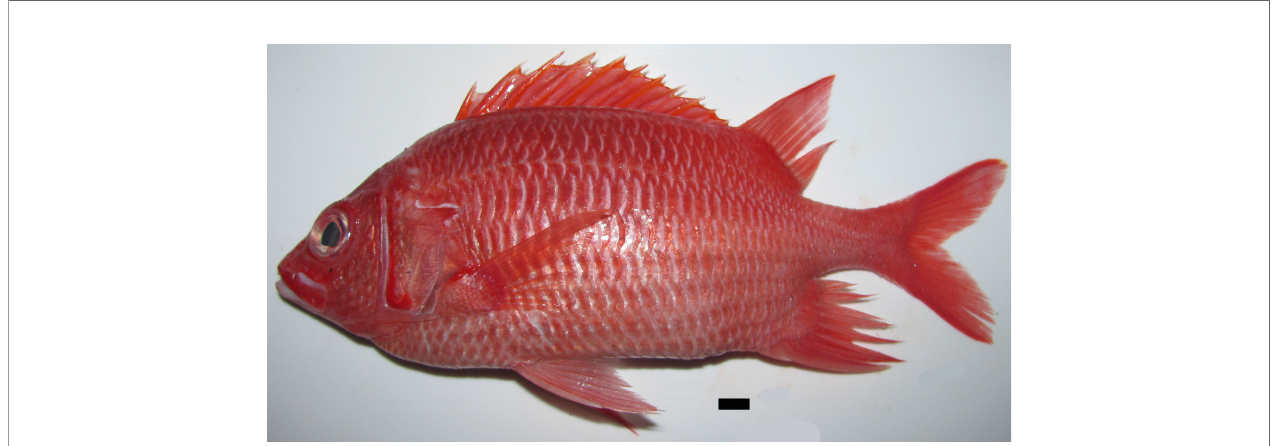
FIGURE 1 | The silverspot squirrel fi sh Sargocentron caudimaculatum caught out of the Cape Bon